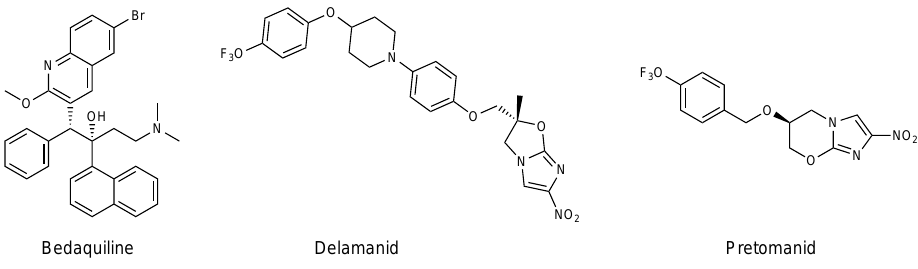
Figure 3. Structure of new compounds in the third phase of clinical trials